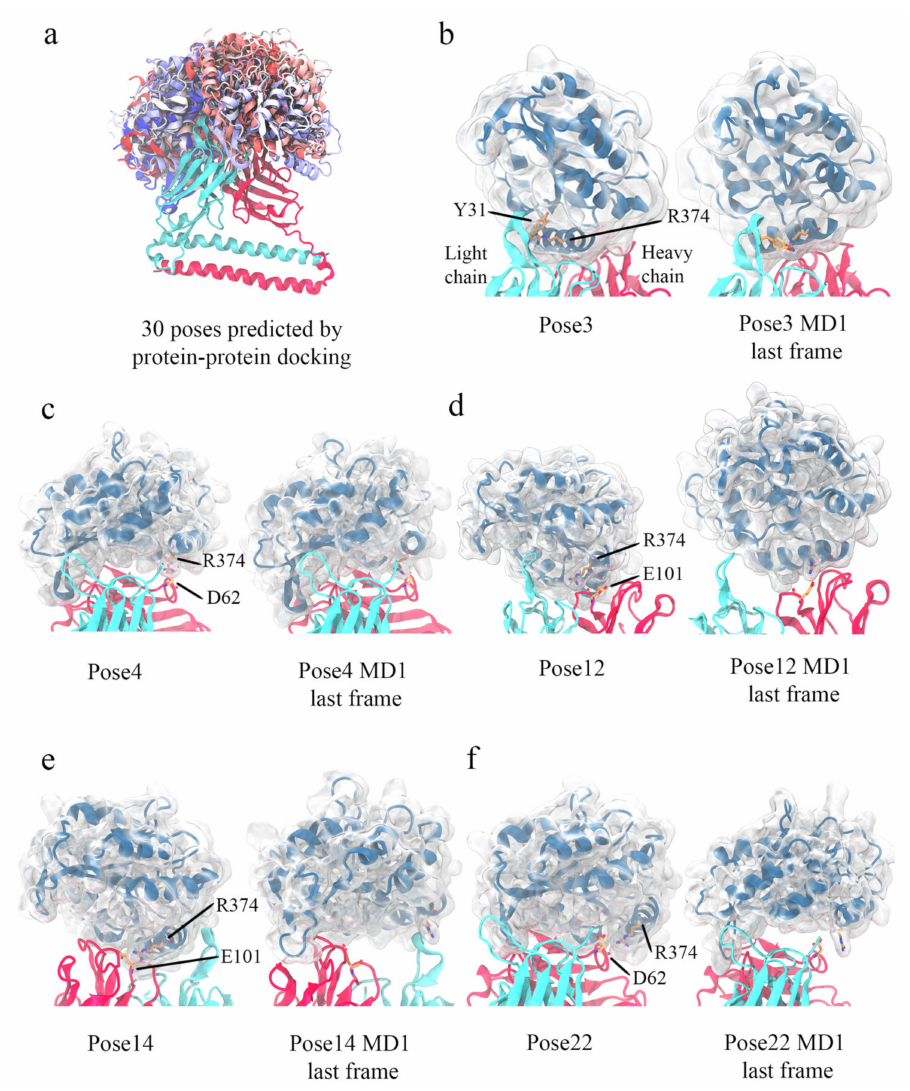
Figure 7. Possible A3Bctd-5G7 binding poses. ( a ) All 30 binding modes of A3B-5G7 predicted by ClusPro program. 5G7 is depicted in cyan and red ribbons for light and heavy chains, respectively. Each A3B pose is shown in ribbons colored differently in a spectrum from blue to red. ( b – f ) The five binding modes that have A3B Arg374 at the interface. For each binding pose, the initial binding mode is shown side-by-side with the final frame of MD1. 5G7 is depicted the same as in ( a ). A3B is shown with blue ribbons in addition to its transparent protein surface. For each case, A3B Arg374 and its interacting partner in 5G7 are depicted in sticks with C atoms in orange, O atoms in red, and N atoms in